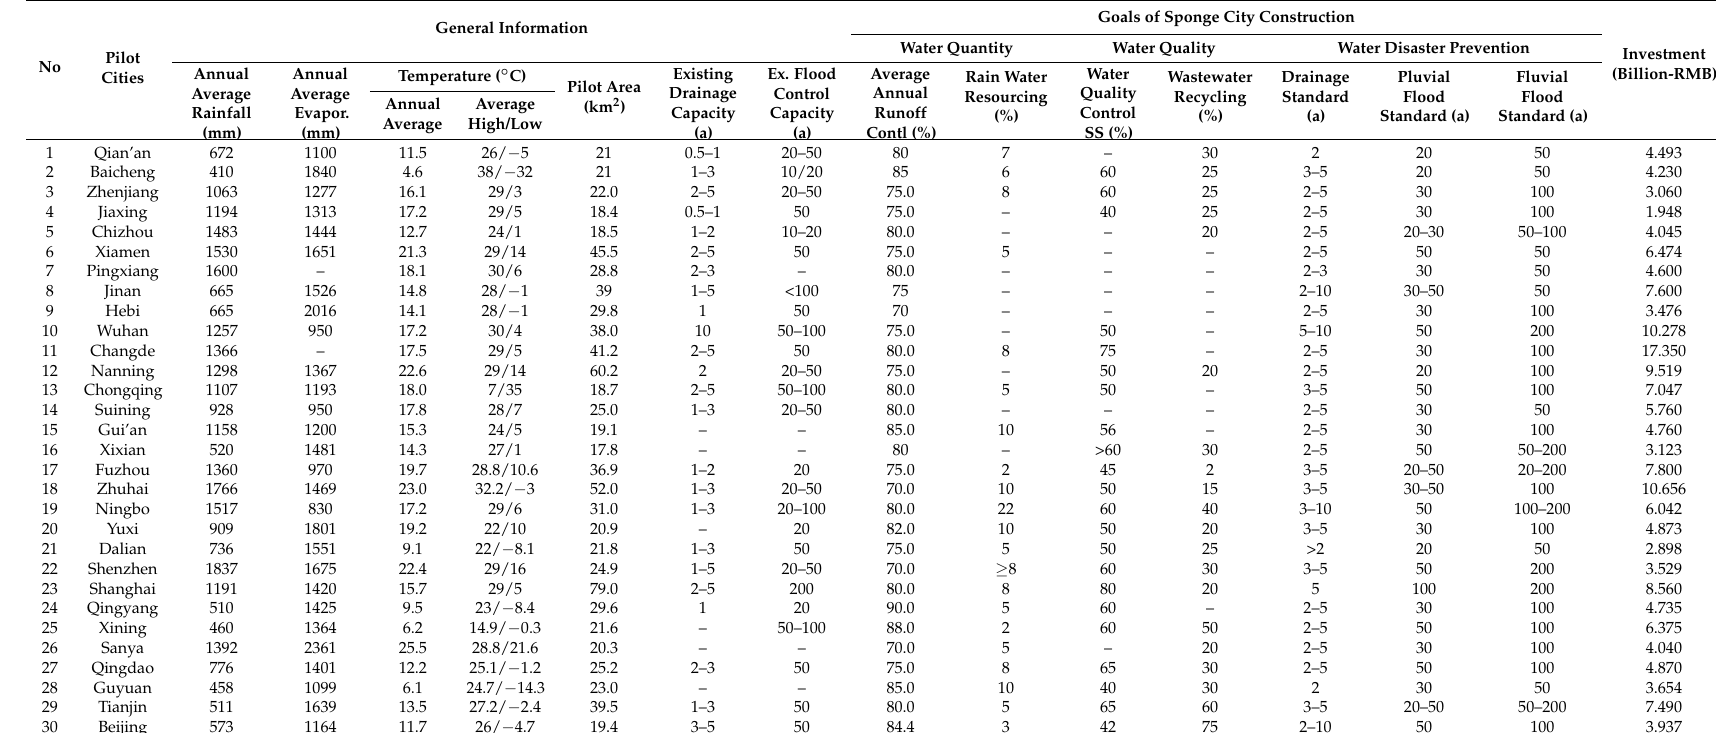
Table A1. Regional characteristics and general information of pilot sponge